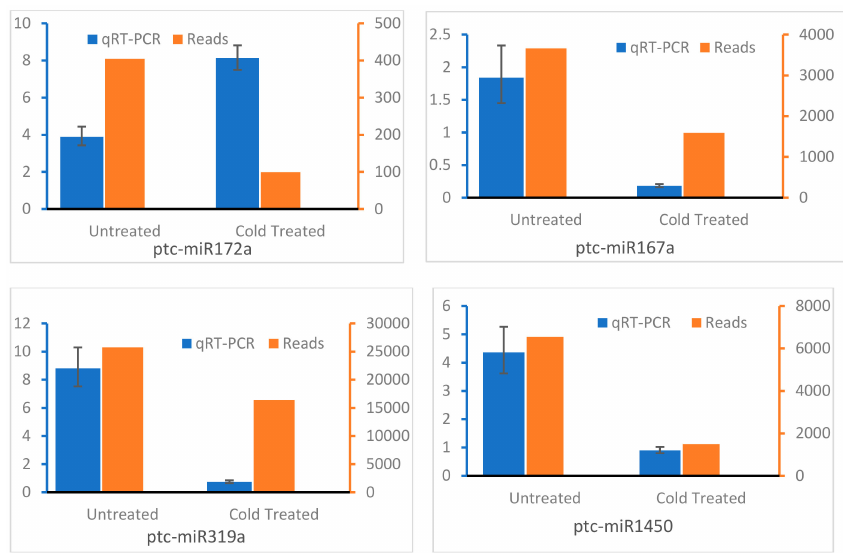
Figure 5. Comparing qRT-PCR data to reads analysis of candidate miRNAs in shoot of Populus simonii × P. nigra with and without cold treatment.